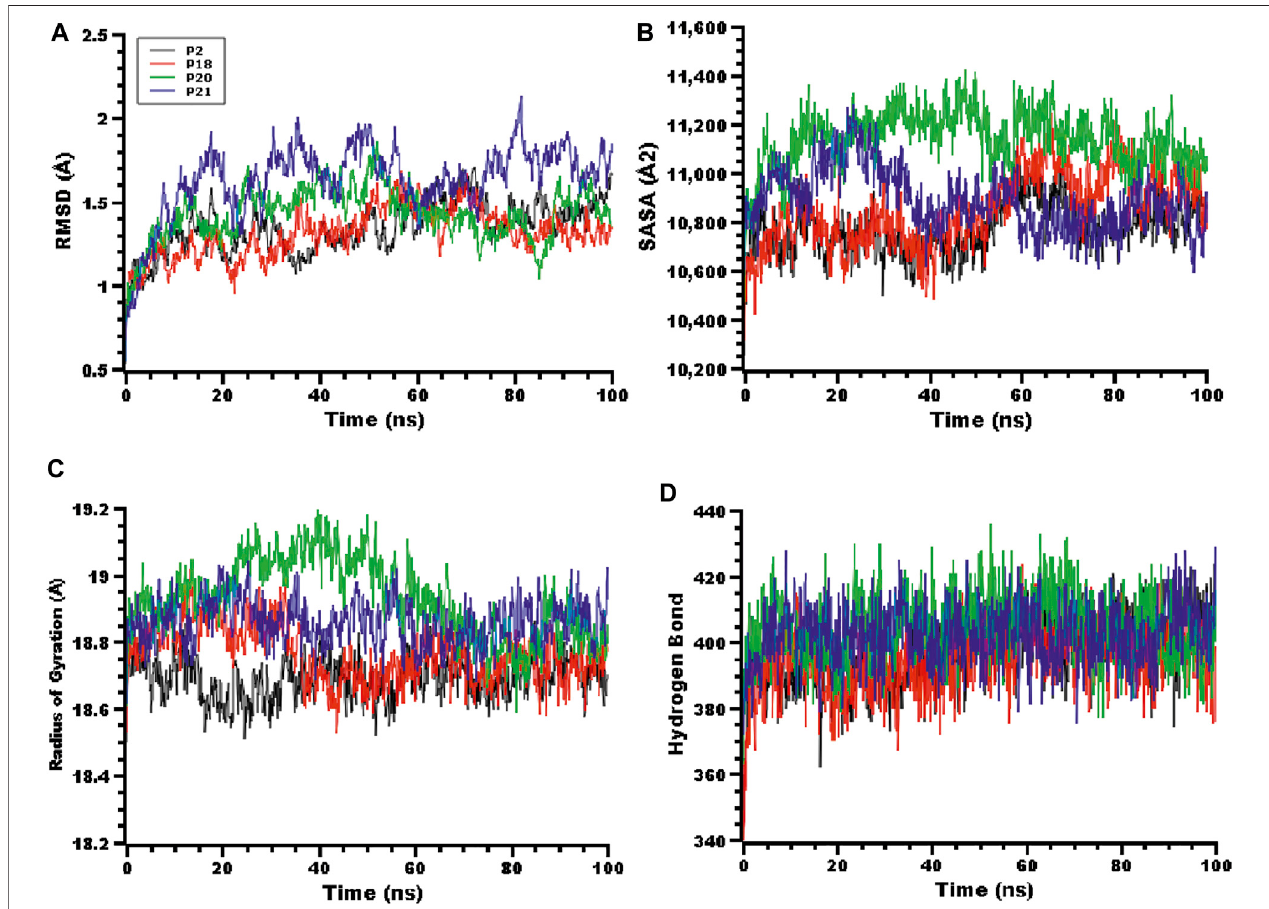
FIGURE 3 | The molecular dynamics simulation of the peptides and RBD complex, here (A) root mean square deviation (RMSD) of the alpha carbon atom, (B) solvent accessible surface area (SASA), (C) radius of gyration (Rg), (D) hydrogen bonding of the complexes to estimate their stability in the simulation time.